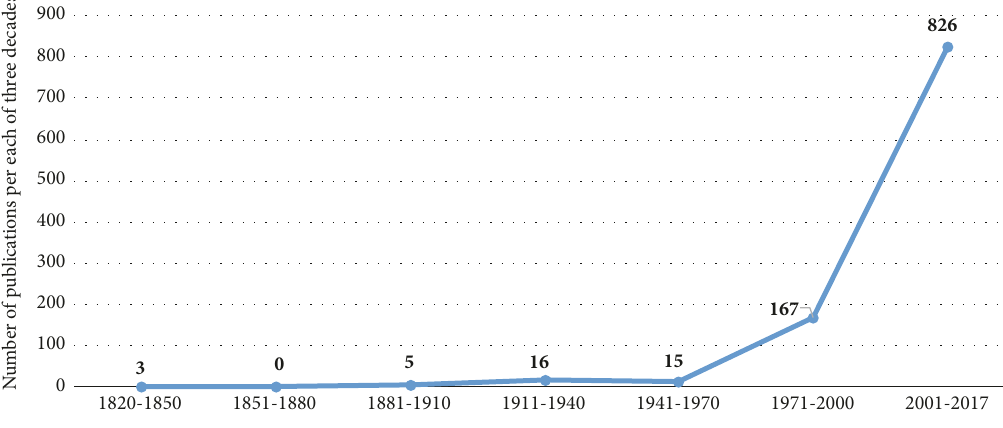
Figure 3: Pattern of publications from the Far-Eastern Himalayan Landscape.